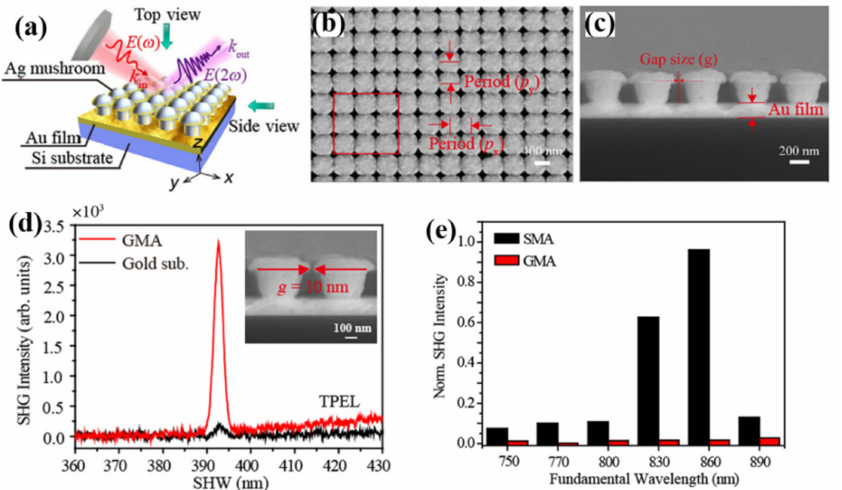
Figure 6. ( a ) Schematic diagram of the fabrication of metal mushroom arrays. ( b ) The top view of SEM characterization of SMA. ( c ) A single Ag mushroom has a height of 220 nm and a diameter of 300 nm, which is the side view. ( d ) Signal comparison of GMA and SHG on the surface of Au film substrate. TPEL is expressed as two-photon excitation should. Inset is the SEM characterization of GMA. ( e ) Fundamental wavelength-dependent comparison of PESHG performance of SMA and GMA [44]. Republished with permission from Ref. [44]. Copyright 2022 American Physical